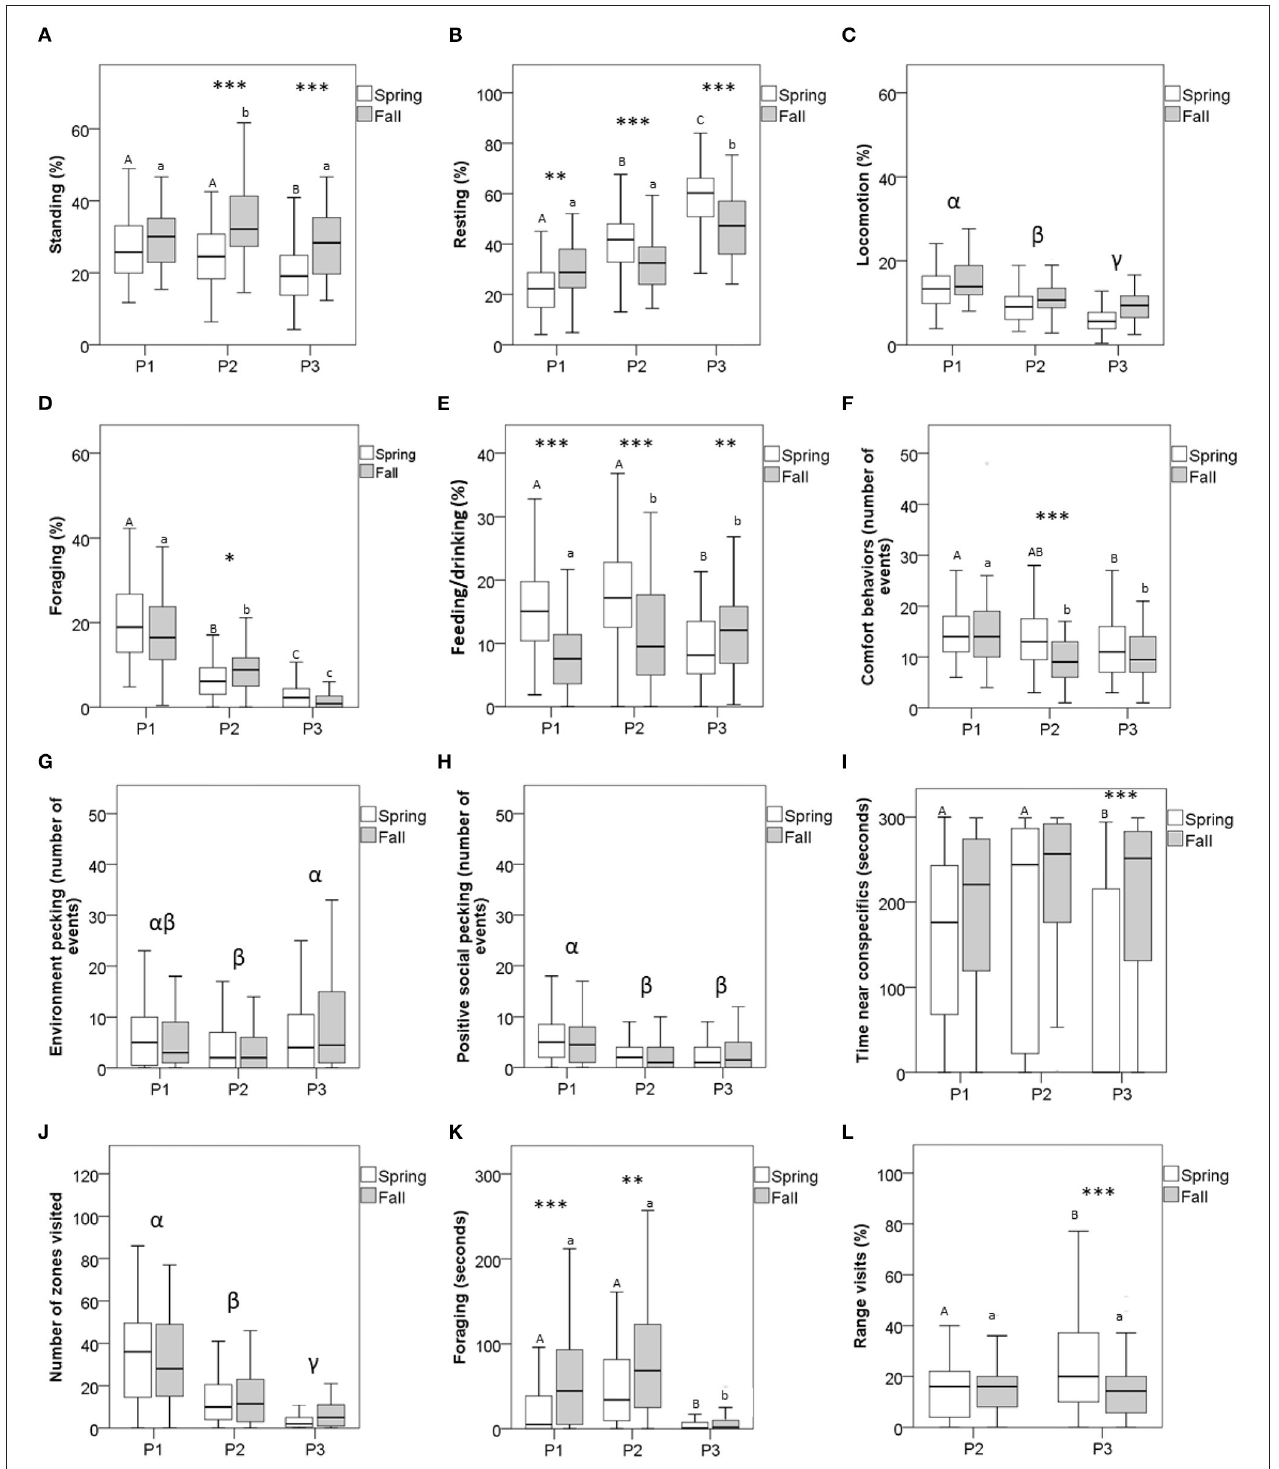
FIGURE 2 | Mean expression of the behaviors of male broiler free-range chickens in both their home environment and in the test situations (Social motivation and exploration tests) at three different periods of their ontogeny (P1 - before range access, P2 - early range access, and P3 - late range access), and two different seasons (spring and fall, n = 59 and n = 58, respectively). State behaviors are presented in (A) Standing, (B) Resting, (C) Locomotion, (D) Foraging, and (E) Feeding/Drinking. Events behaviors are presented in (F) Comfort behaviors, (G) Environment pecking, and (H) Positive social pecking. Results of tests are presented in (I) Time near conspecifics, (J) Number of zones visited, (K) Foraging, and (L) Number of range visits. Asterisks indicate significant differences between the seasons at each period.